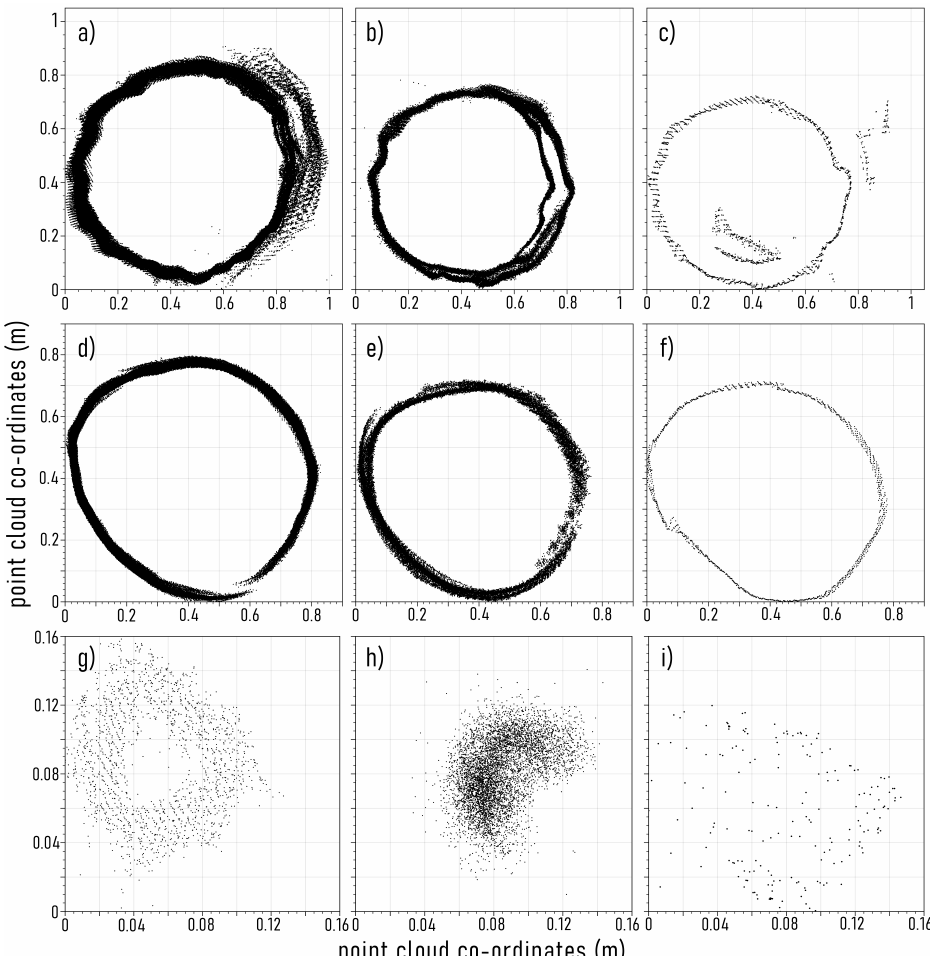
Figure 7. Examples of depth image misalignment error, from the continuous stem capture ap- proach, as a result of incidental duplicate captures, with ( a ) Microsoft Kinect, ( b ) Apple iPad, and ( c ) Stereolabs Zed 2 colour and depth (RGB-D) devices (TLS DBH = 74.8cm); and examples of depth image misalignment error as a result of simultaneous localisation and mapping (SLAM) drift with ( d ) Microsoft Kinect, ( e ) Apple iPad, and ( f ) Stereolabs Zed 2 colour and depth (RGB-D) devices